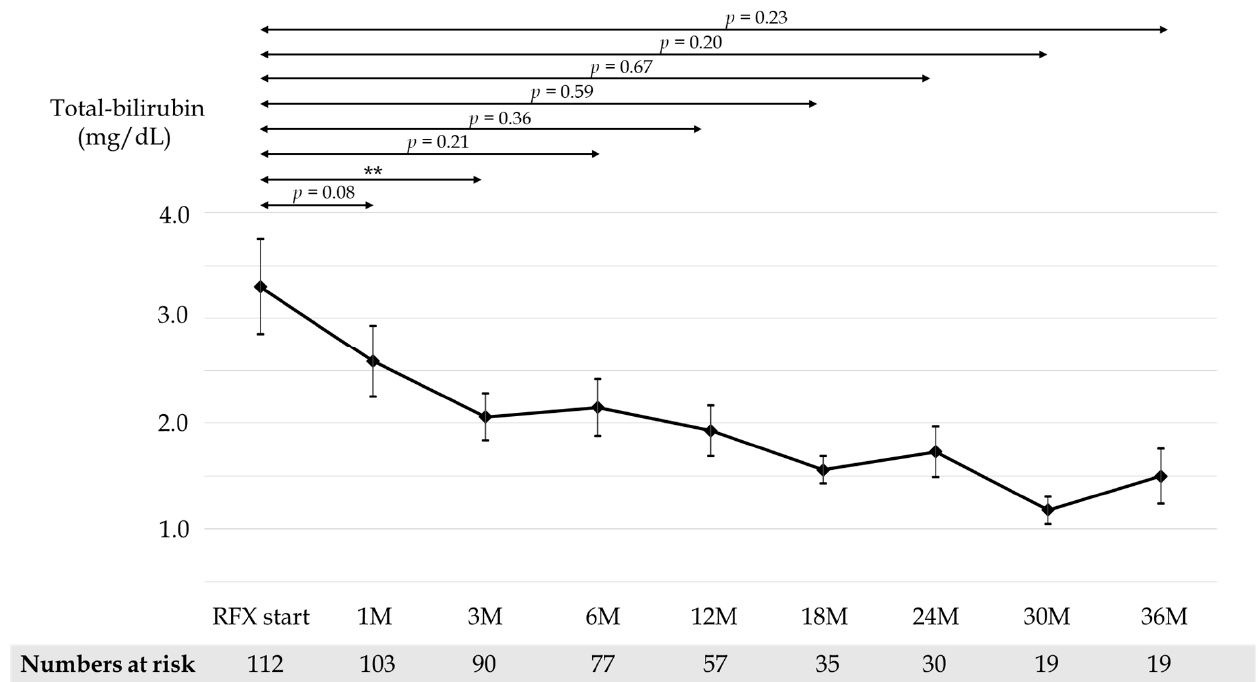
Figure 6. Changes in mean total-bilirubin before and 1, 3, 6, 12, 18, 24, 30, and 36 months after RFX administration. p -values were determined using the Wilcoxon signed-rank test ( p < 0.1 tendency differences, p < 0.01 **). RFX, rifaximin.